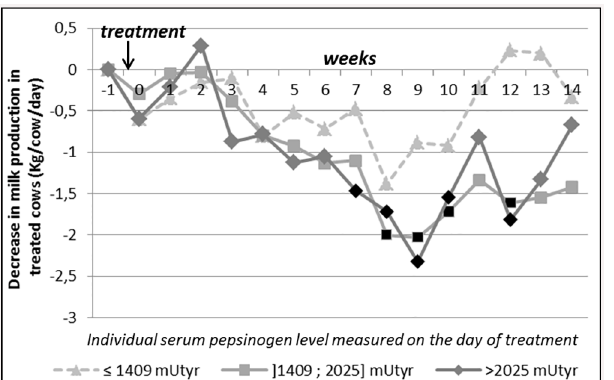
Fig 4. Evolution of the treated cows ’ milk production over time in comparison with control cows (G i s) according to serum pepsinogen level at the time of treatment (second visit, 1.5 to 2 months after turn- out). Week 0 = week of treatment, the first day of week 0 is the day of treatment. Black dots on the curve indicate that the corresponding negative G i are significantly different from zero, adjusted p-value < 0.05: